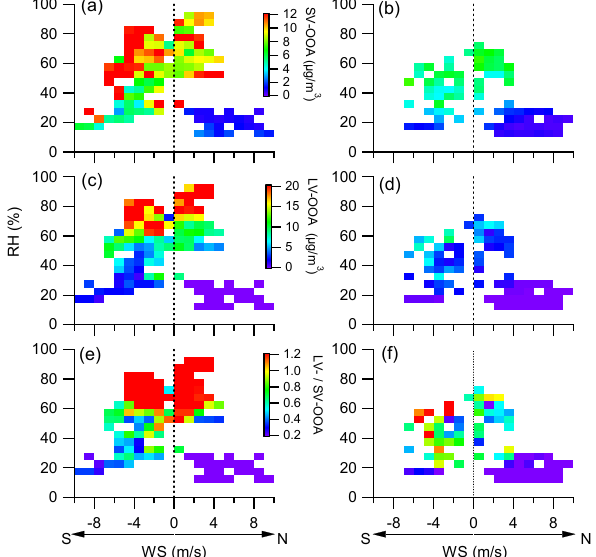
Figure 6. Relative humidity (RH) and wind dependence (WD) of (a, b) semi-volatile oxygenated organic aerosols (SV-OOA), (c, d) low-volatility oxygenated organic aerosols (LV-OOA), and (e, f) the ratio of LV-OOA/SV-OOA measured before (left panel) and during the Asia-Pacific Economic Cooperation (APEC) sum- mit (right panel). S refers to the south (90 ◦ <WD<270 ◦ ), and N refers to the north (0 ◦ <WD<90 ◦ and 270 ◦ <WD<360 ◦ ). Grids with points numbering less than five were excluded.